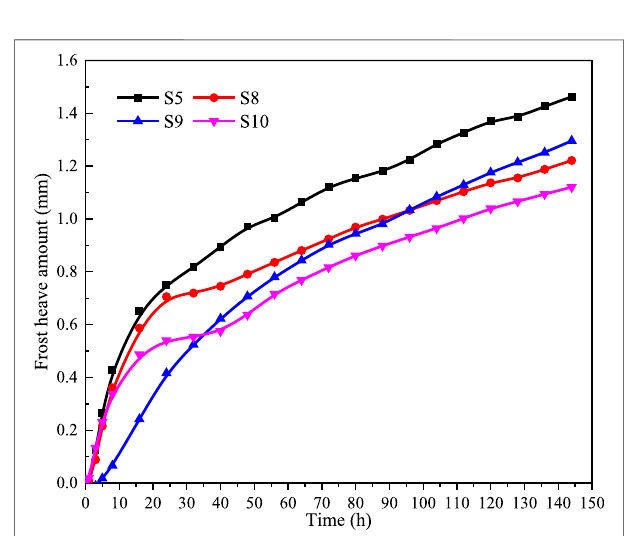
FIGURE13| Frostheaveforsampleswithvariousgrainsizedistributions of coarse particles.